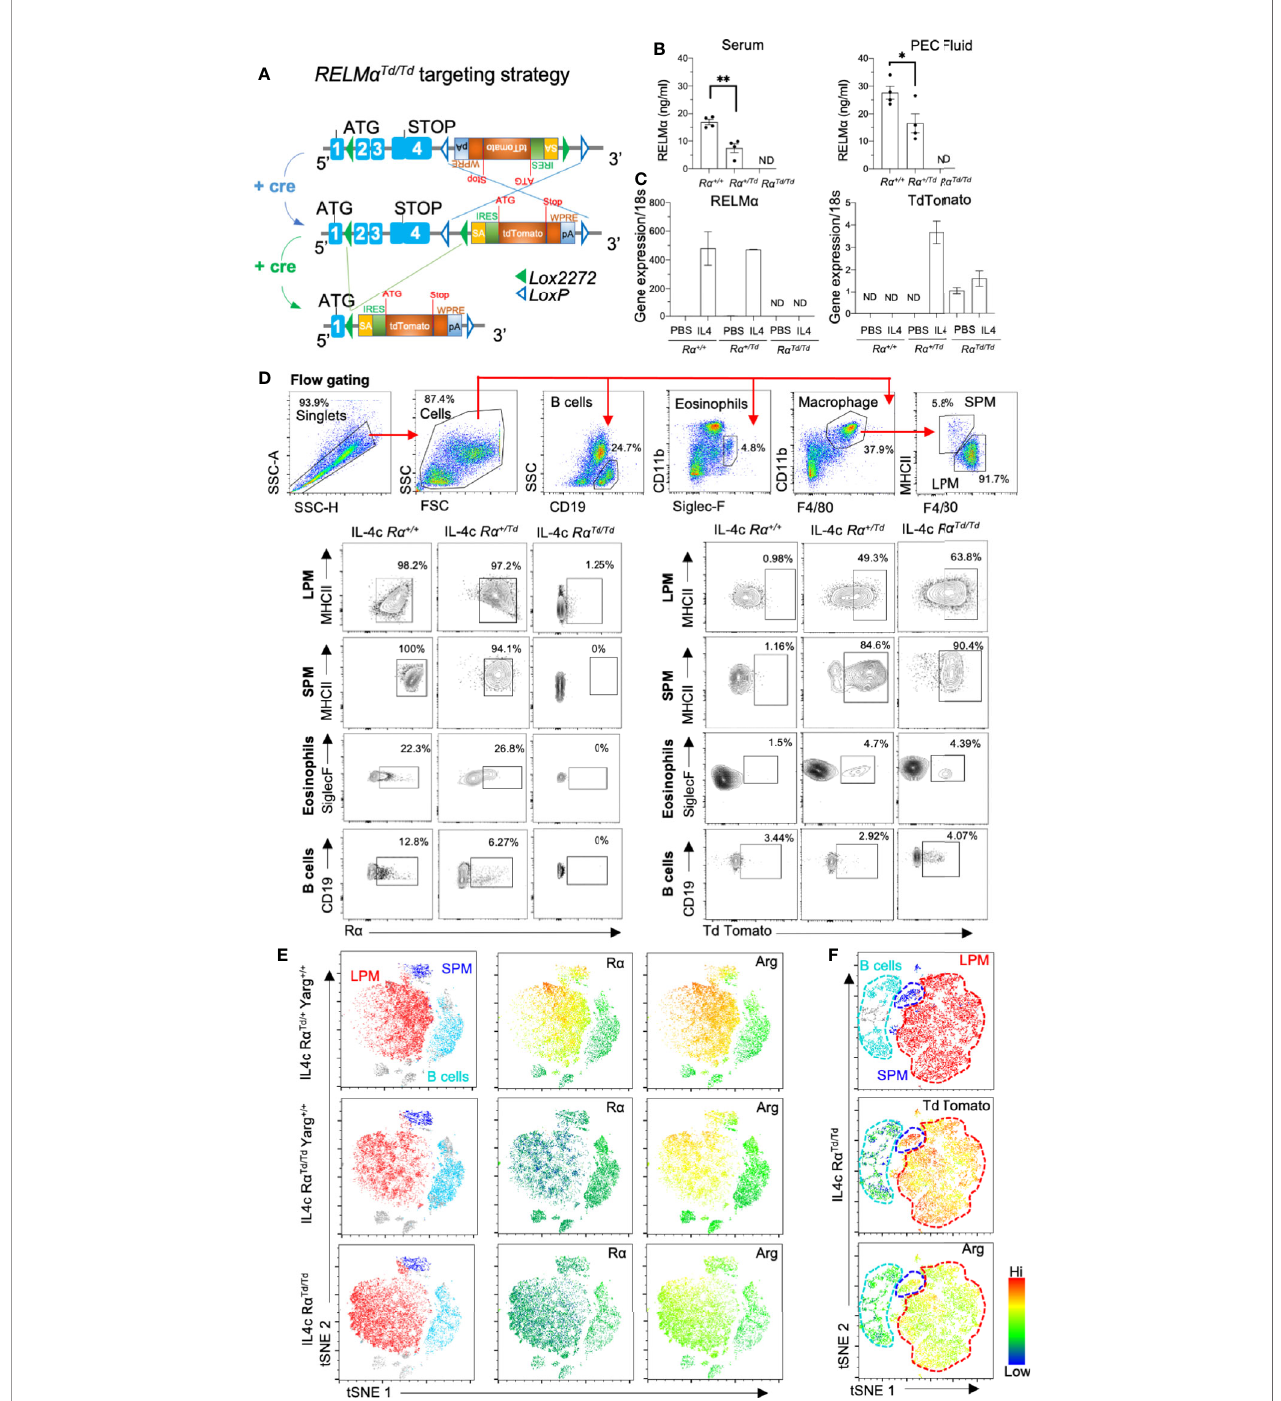
FIGURE 1 | Validation of RELM a reporter transgenic mice. RELM a (R a ) or TdTomato (Td) reporter homozygote and heterozygote mice were intraperitoneally injected with PBS or IL-4c (2.5 m g IL4/mouse) at day 0 and 2, then sacri fi ced at day 4. (A) Targeting strategy for RELM a deletion and replacement with Td reporter gene. (B) RELM a ELISA of serum and peritoneal fl uid of 6 – 8 weeks mice. (C) RELM a and Td qRT-PCR of peritoneal cells treated in vitro for 24h with IL-4 (20ng/ml), presented as relative expression to PBS and normalized to 18s transcript. R a expression was normalized to the PBS R a +/+ group (set at “ 1 ” ) (D) Flow cytometry gating and analysis of large and small peritoneal cells (LPM and SPM), eosinophils and B cells from IL4c-injected mice for Td and RELM a protein. (E, F) t-SNE -guided analysis of peritoneal cavity cells subsets gated according to 1D (LPM, red; SPM, blue; B1 cell, cyan) for expression of R a , Arg YFP and Td employing R a Td and Yarg reporter mice. Results shown are combined from 2-3 independent experiments (n=4-12), apart from (C, E) which is one experiment, n=3 replicates. ND, not detected. *, p ≤ 0.05; **, p ≤